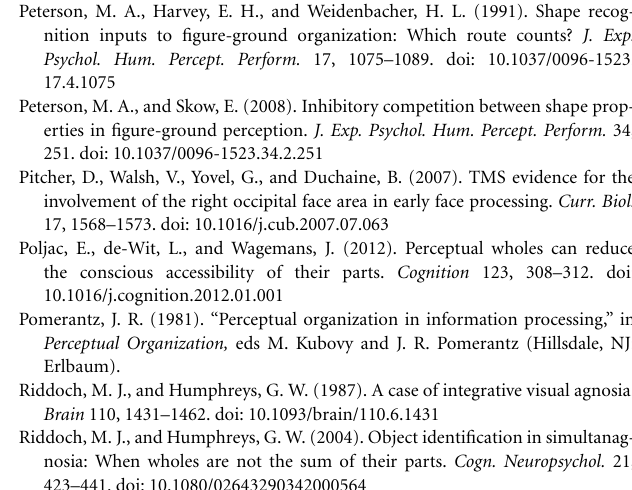
figure-ground organization: Operations on outlines and subjective contours. Percept. Psychophys. 56, 551–564. doi: